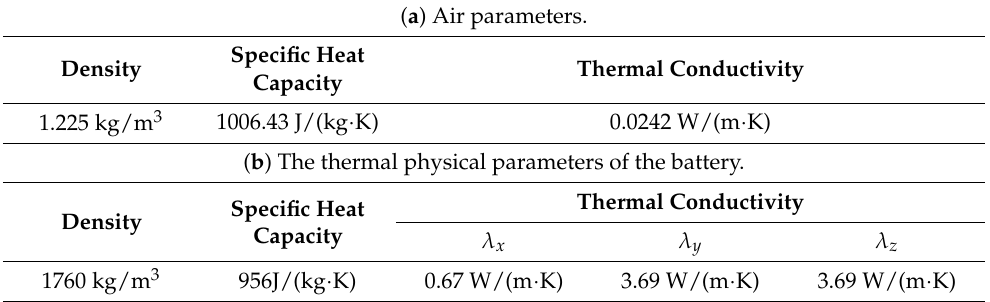
Table 2. ( a ) Air parameters. ( b ) The thermal physical parameters of the battery. ( a ) Air parameters. Specific Heat Density